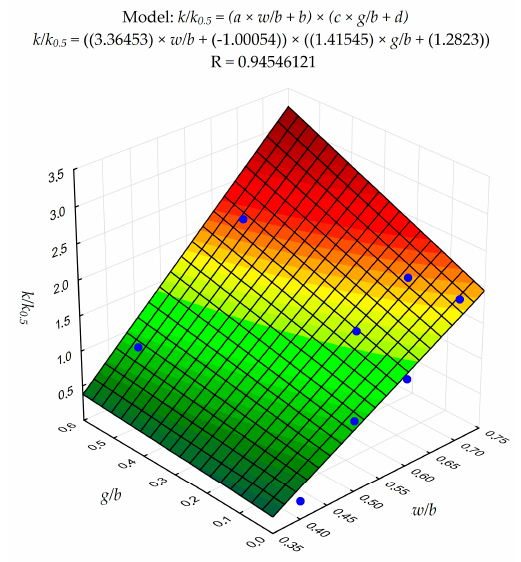
Figure 2. Carbonation coefficients k / k 0.5 model plotted against w / b and g / b with best regression for concrete with granulated blast-furnace slag (GGBS).